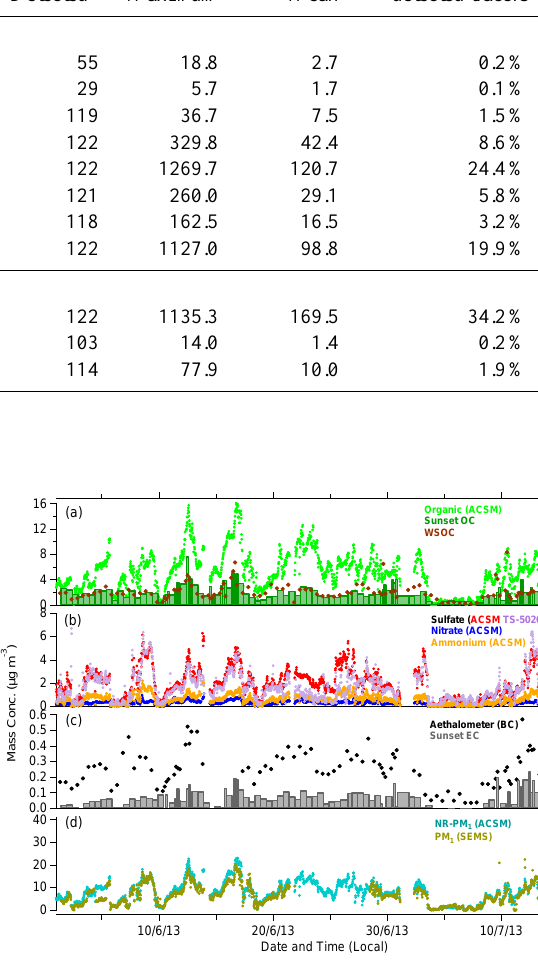
Figure 1. Time series mass concentration of (a) organic and (b) in- organics (excluding chloride) measured by ACSM, (c) black car- bon (BC) measured by Aethalometer, and (d) NR-PM 1 and PM 1 mass concentrations measured by ACSM and SEMS-MCPC. Col- located sulfate aerosol measured by Thermo Scientific Sulfate An- alyzer was plotted on (b) . OC (bars) and WSOC (dots), both in unit of µgCm − 3 , measured from filter samples were plotted on (a) with ACSM organic. EC (bars; in unit of µgCm − 3 ) measured from filter samples were plotted on (c) along with BC